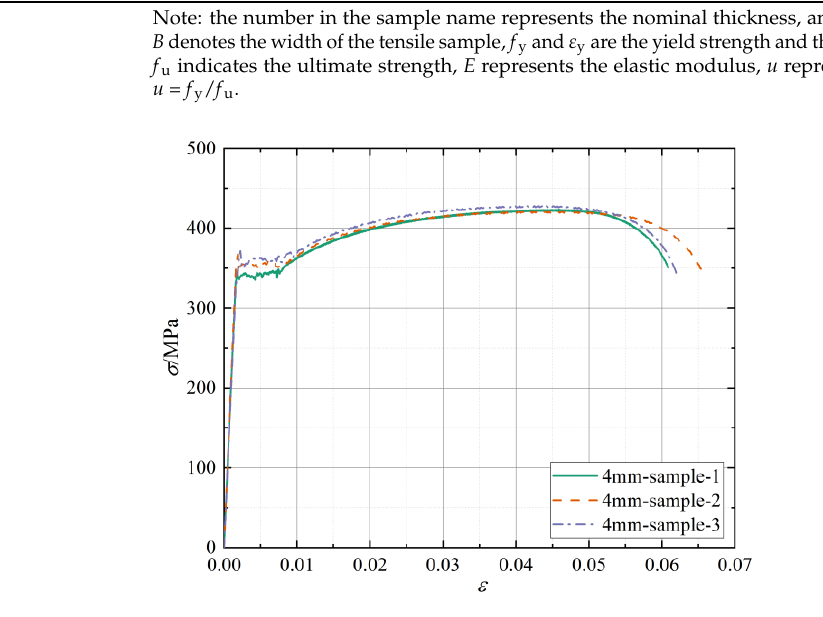
Figure 5. Stress – strain curve of 4-mm thick tensile steel sample.